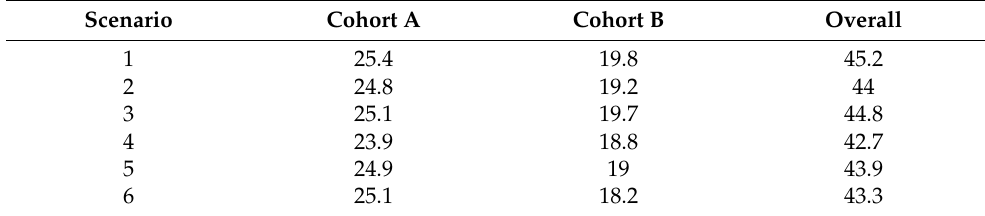
Table 5. Average sample size across